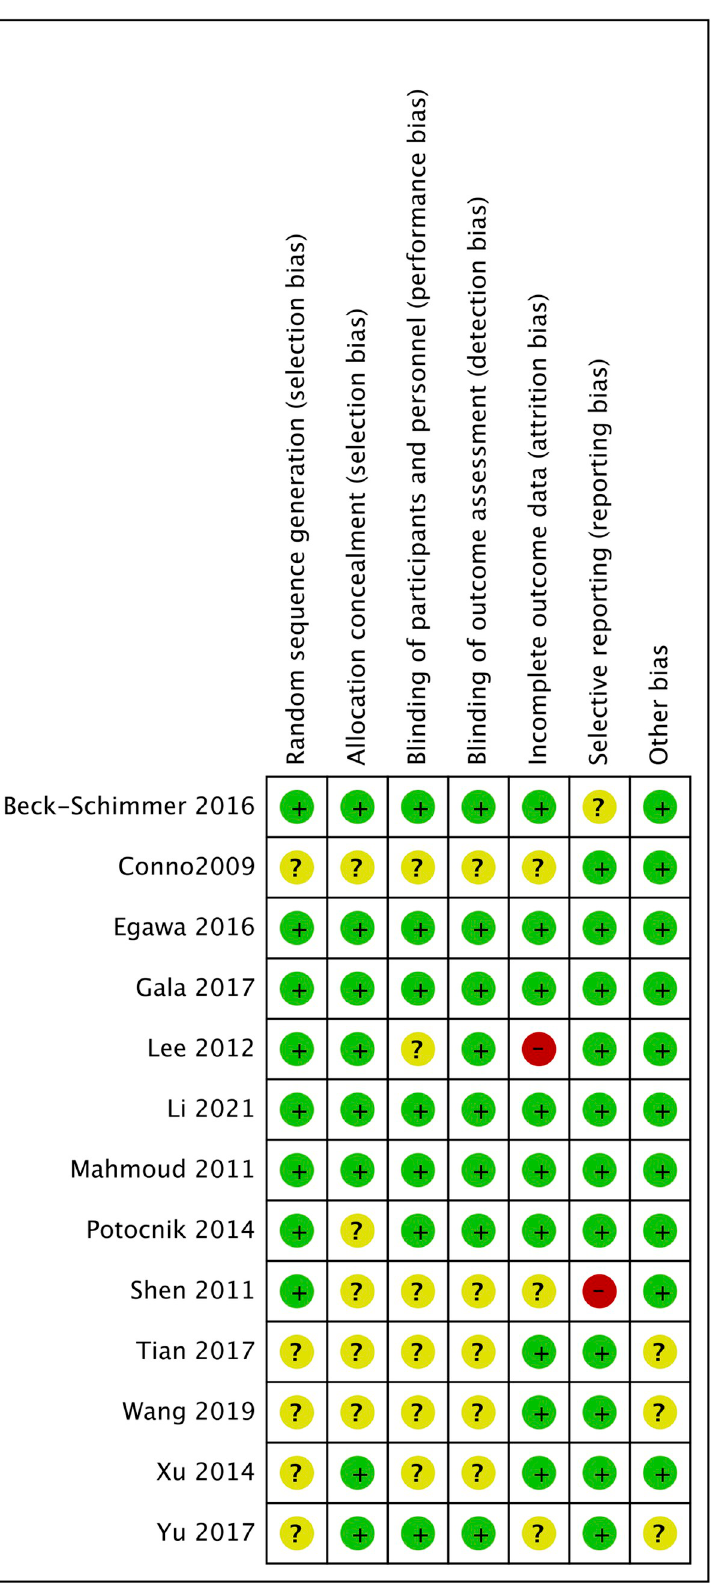
Fig 2. A summary of assessment of risk bias of each